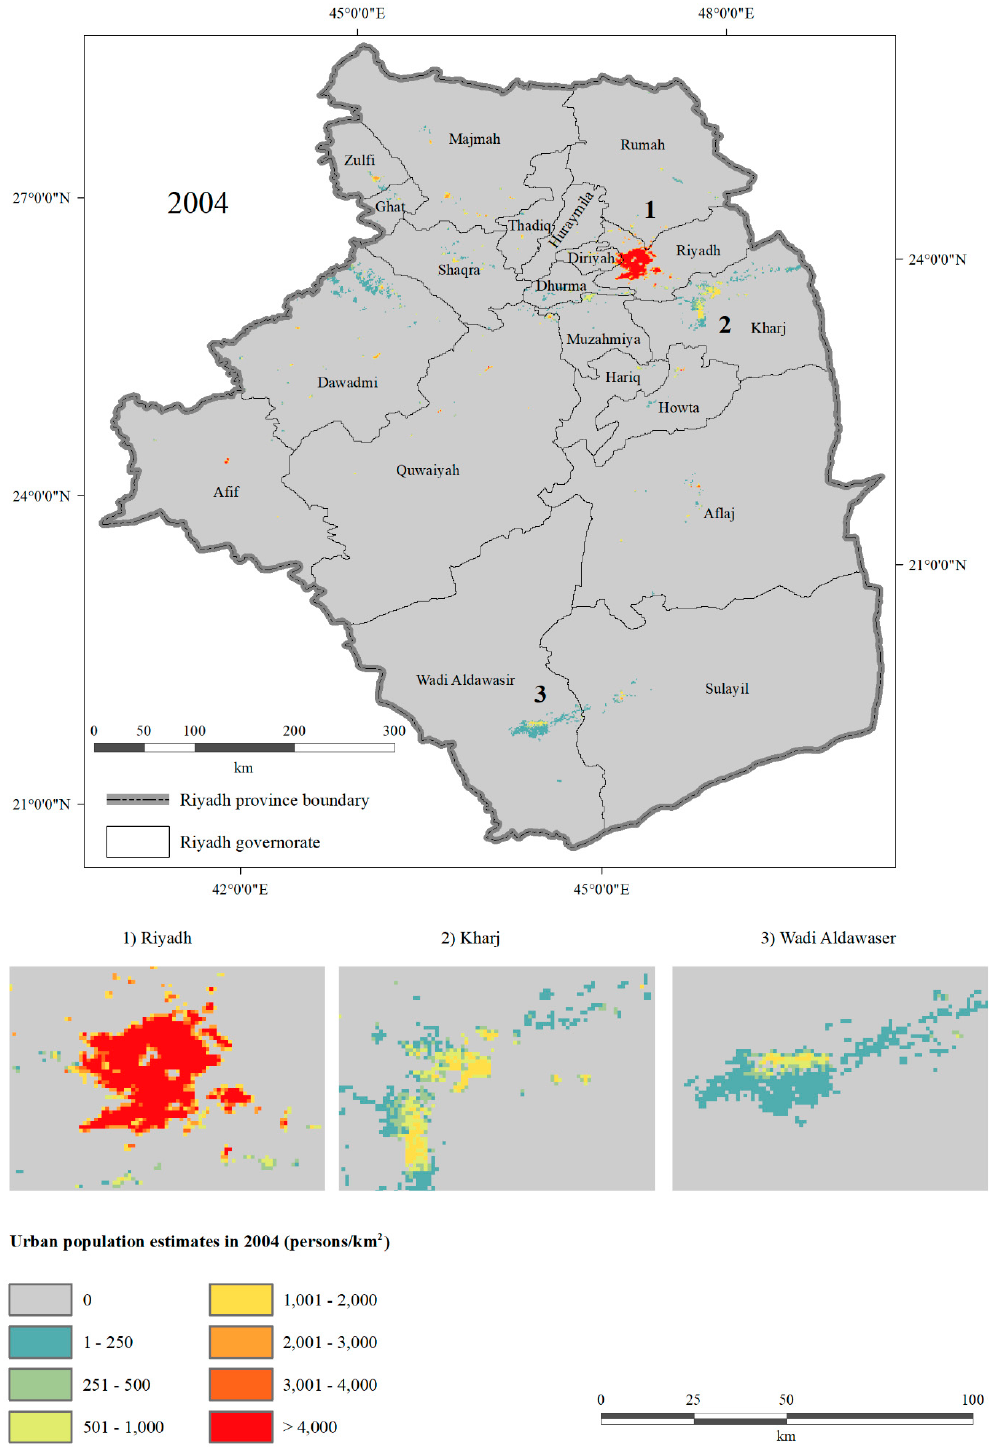
Figure 8. Spatial pattern of population estimates in Riyadh province in 2004.